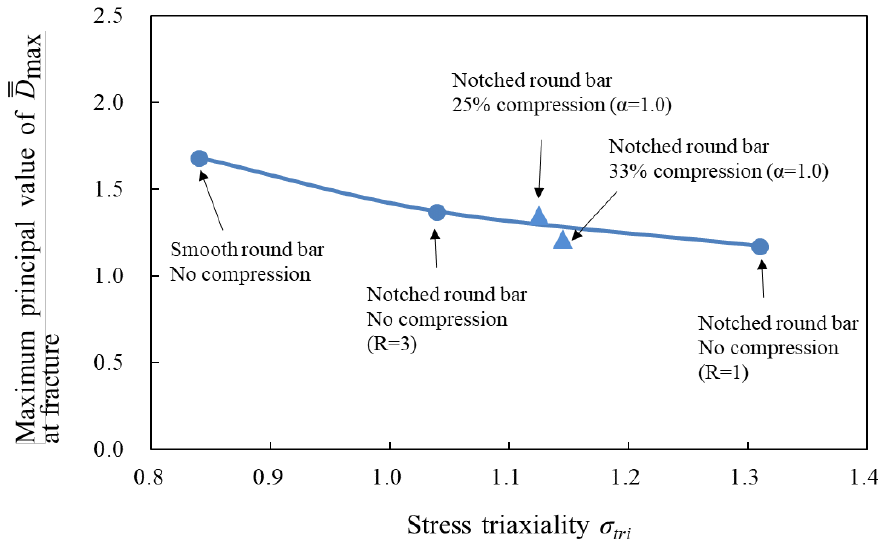
Figure 13. Maximum principal damage change against stress triaxiality (Specimen A).